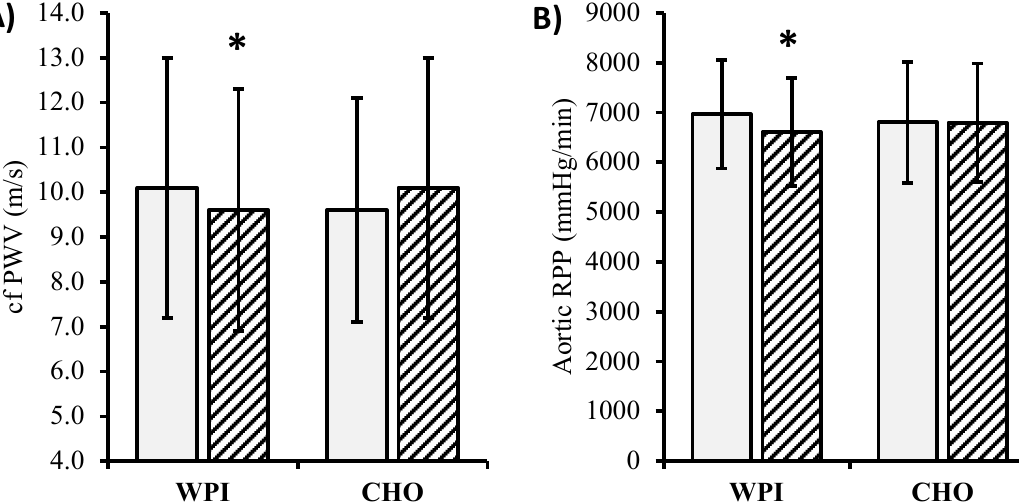
Figure 2. Changes in ( A ) aortic stiffness (cf PWV) and ( B ) aortic rate pressure product (RPP) from baseline to 12 wks in WPI (whey protein isolate) vs. CHO (carbohydrate) (mean ± SD). Effects, p -value (partial η 2 ). * p < 0.05 vs. baseline. (A) Group 0.88(0.00); time 0.88(0.00); G × T 0.01(0.00) ; df 96. (B) Group 0.96(0.00); time 0.03(0.05) ; G × T 0.04(0.04) ; df 94. Bold highlights statistically significant effects.